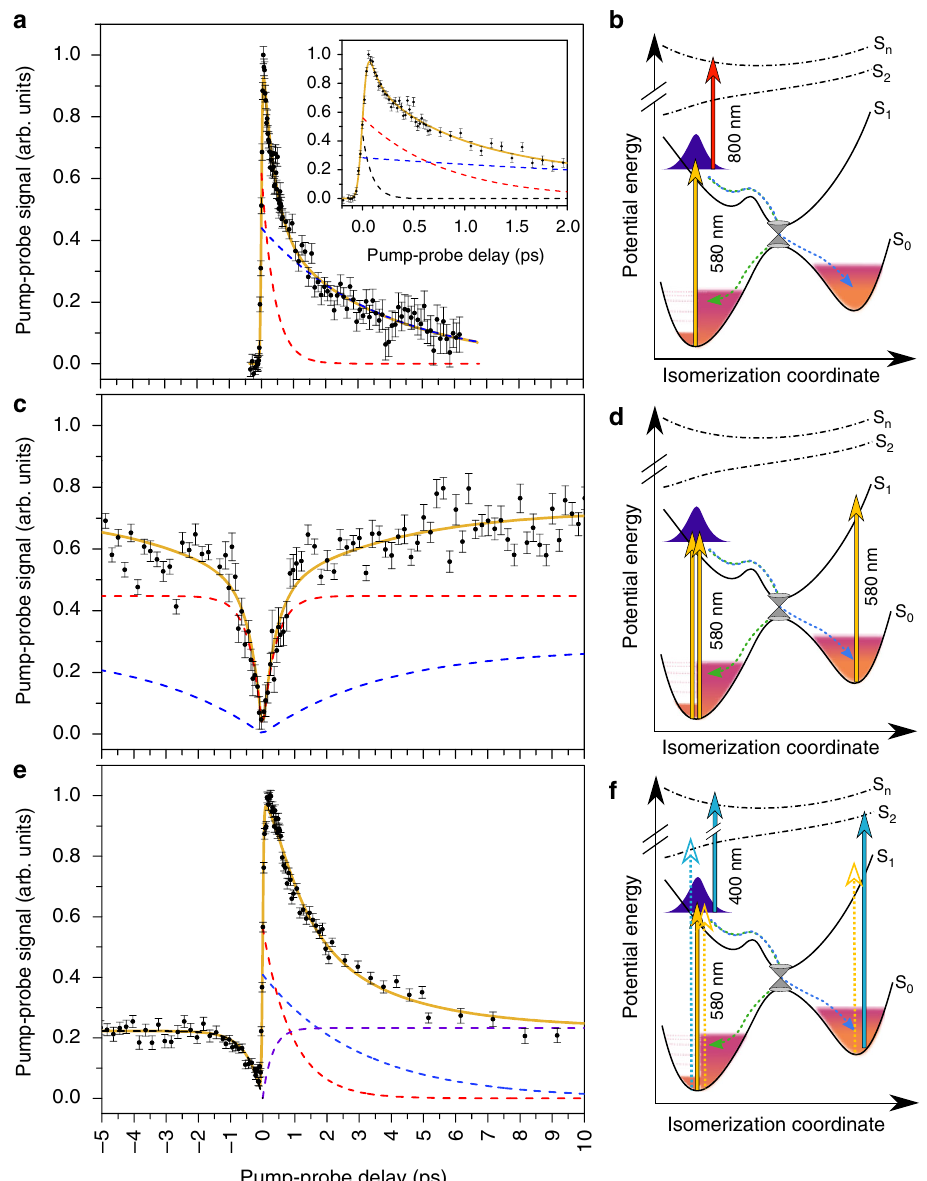
Fig. 2 Pump-probe measurements of retinal protonated Schiff-base (RPSB) in vacuo. a , b Excited-state decay seen as the two-photon, pump-probe signal as a function of delay between pump (580 nm) and probe (800 nm) pulses. The full curve is from a fi t with two exponential functions folded with the 80 fs cross-correlation in the experiment. The dashed lines represent the two decay components in the fi t (395±42fs and 3.7±0.4ps). The insert shows a fi t with three lifetime components, which speci fi cally takes into account the separate early sub ~100 fs dynamics ( fi tted lifetimes 70±20fs, 785±185 fs, and 5.6±1.8 ps). Data with 900nm probe and other pump wavelengths within the S 0 → S 1 absorption band may be found in the Supplementary Table 1. c , d Ground-state recovery revealed by the two-photon, pump-probe signal as a function of delay between pump (580 nm) and probe (580 nm) pulses. The full curve is a fi t with the two lifetimes found from the decay of the excited state (shown in a ). e , f Dynamics revealed by the two-photon, pump-probe signal as a function of delay between pump (580 nm) and probe (400 nm) pulses. The chromophore may here absorb two photons (pump and probe) at all times, except right after excitation to S 2 by 400 nm at small negative pump-probe delays. The fast recovery on the negative time axis is associated with the return to S 0 after initial excitation (400 nm) to S 2 . All data shown here are recorded at room temperature. All error bars presented are one standard deviation